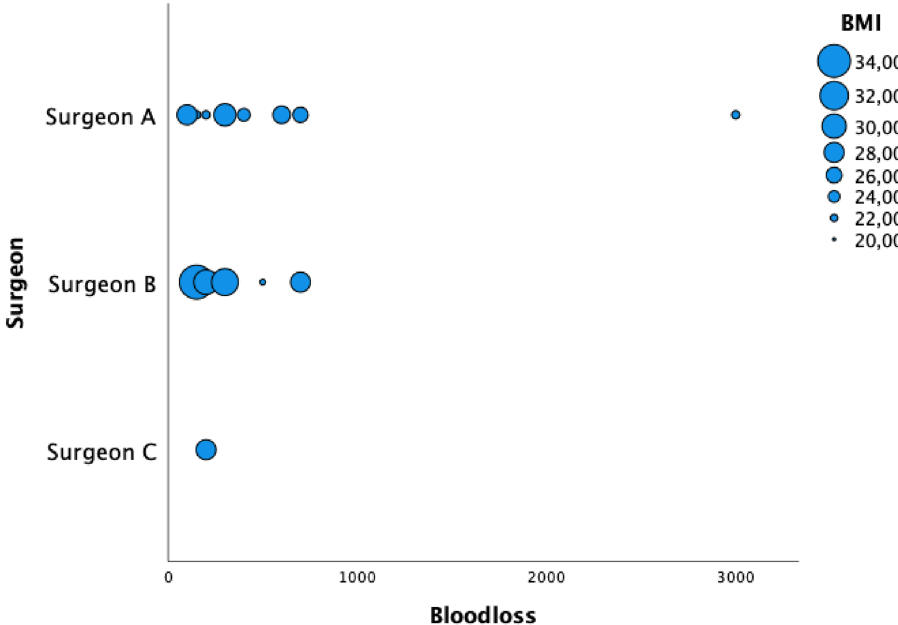
Figure 3. Blood loss distribution based on BMI and surgeon.